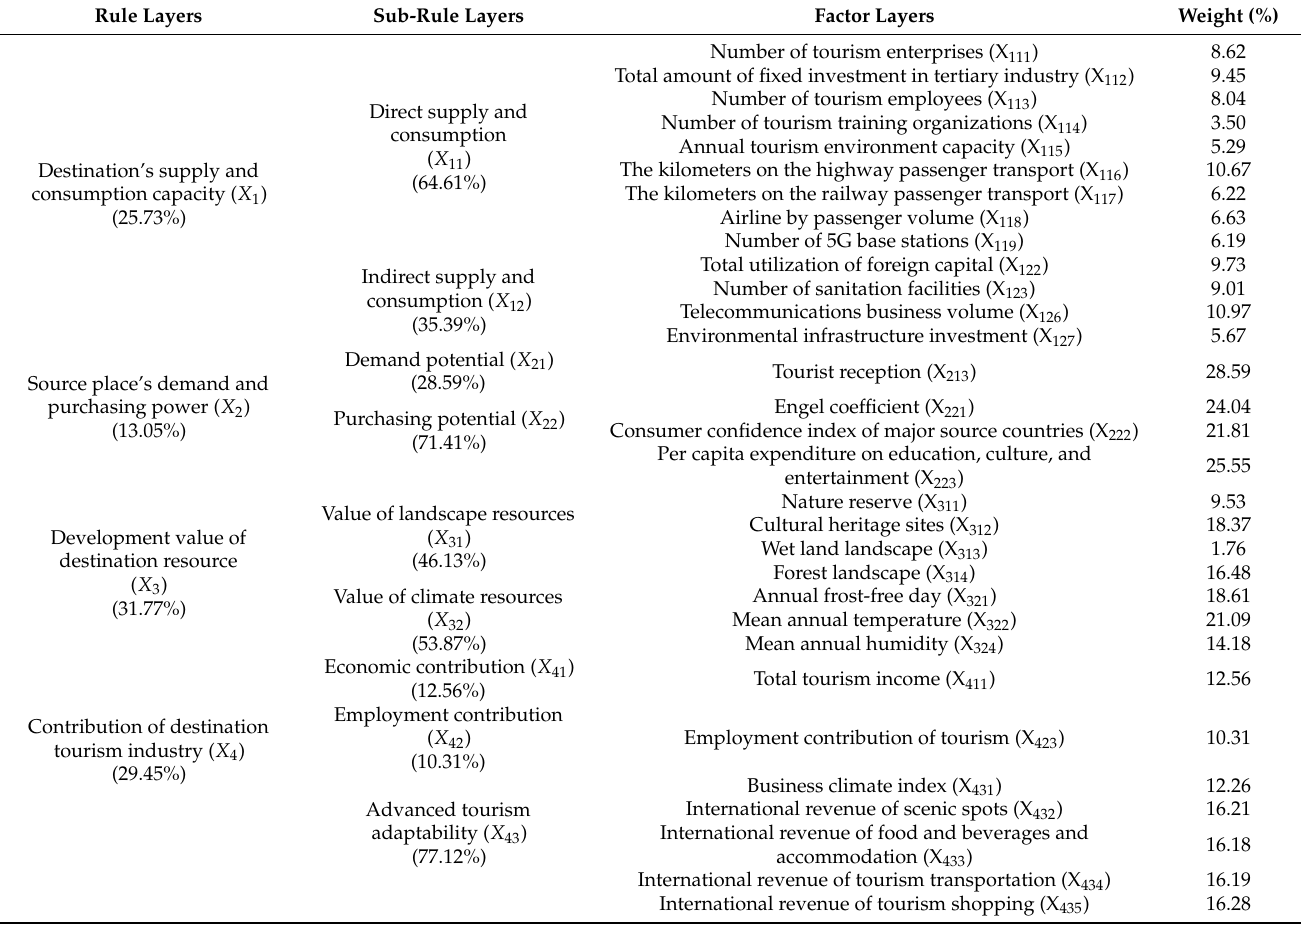
Table 2. Multidimensional Scale for Evaluation of TDP of Provincial Destinations along the Belt and Road in China. Rule